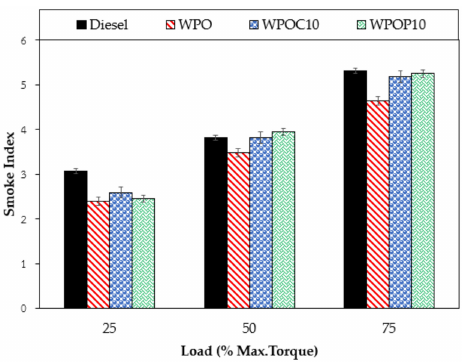
Figure 11. Smoke